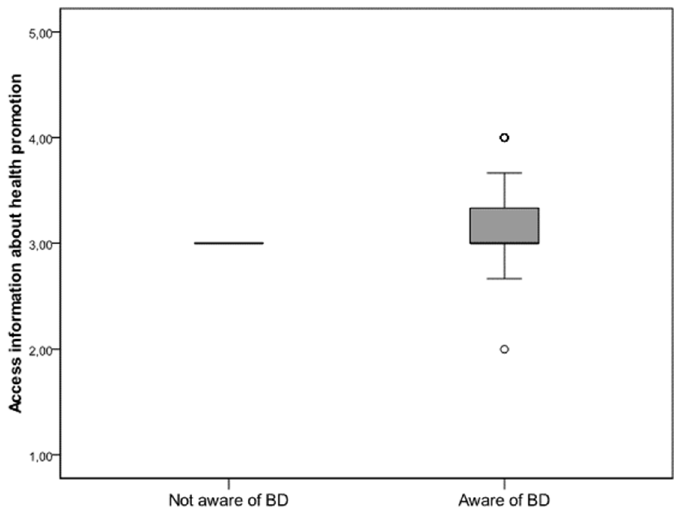
Figure 2. Level of health literacy in regard to BD awareness. Patients aware of their BD could access information about health promotion more easily based on validated HLS-EU-Q47 questionnaires (Mann–Whitney U test; p = 0.03).